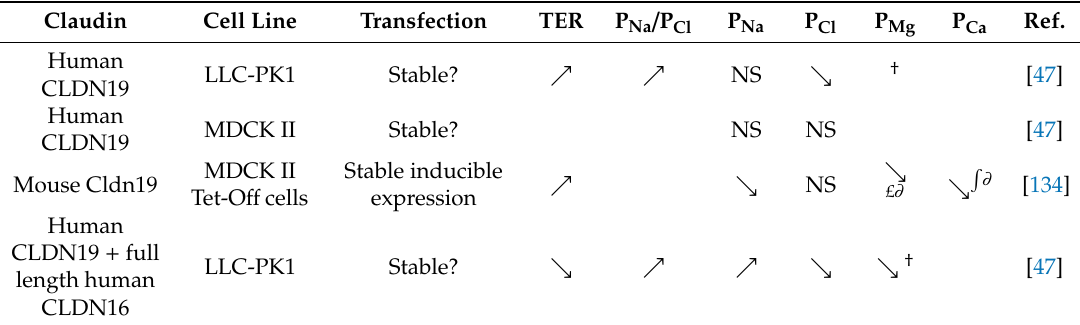
Table 7. Function of claudin 19 and of claudin 16 and claudin 19 co-expression according to heterologous expression studies in cell